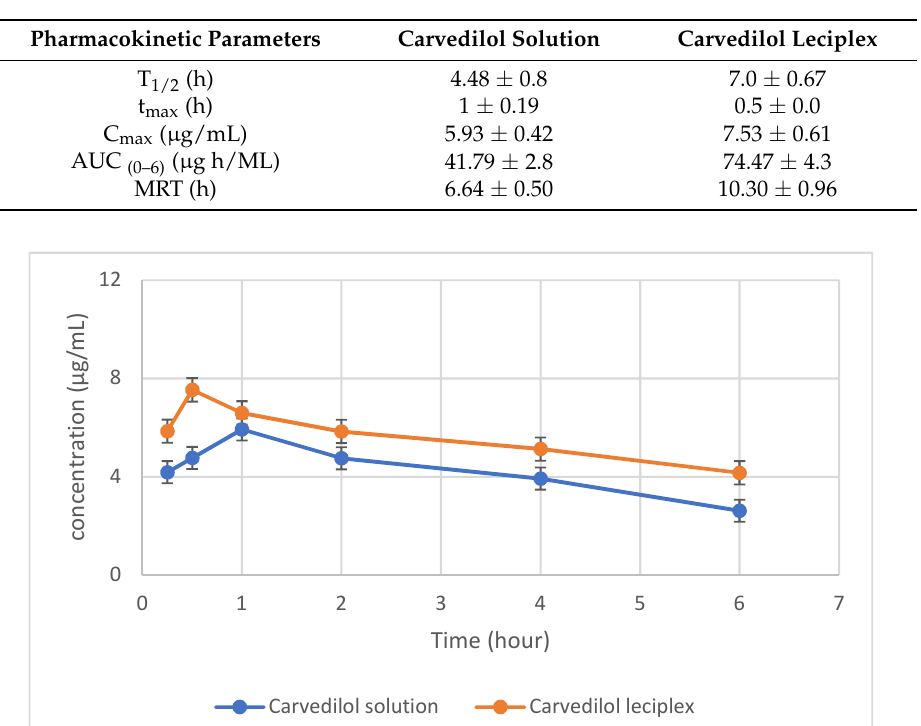
Table 4. Aqueous humor pharmacokinetic parameters of carvedilol leciplex formula and carvedilol solution.